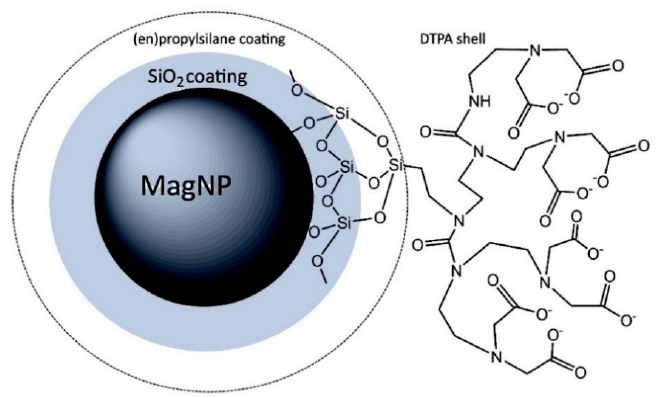
Figure 3. Magnetic nanoparticles protected by a SiO 2 coating, containing an (ethylenediamine)propylsilane shell for supporting the covalently bound DTPA molecules, Fe 3 O 4 @SiO 2 /EAPS/DTPA, or simply NP@DTPA (adapted with permission from [29]).